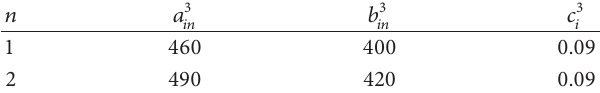
Table 6: Coefficients of unit capacity cost of wind power.